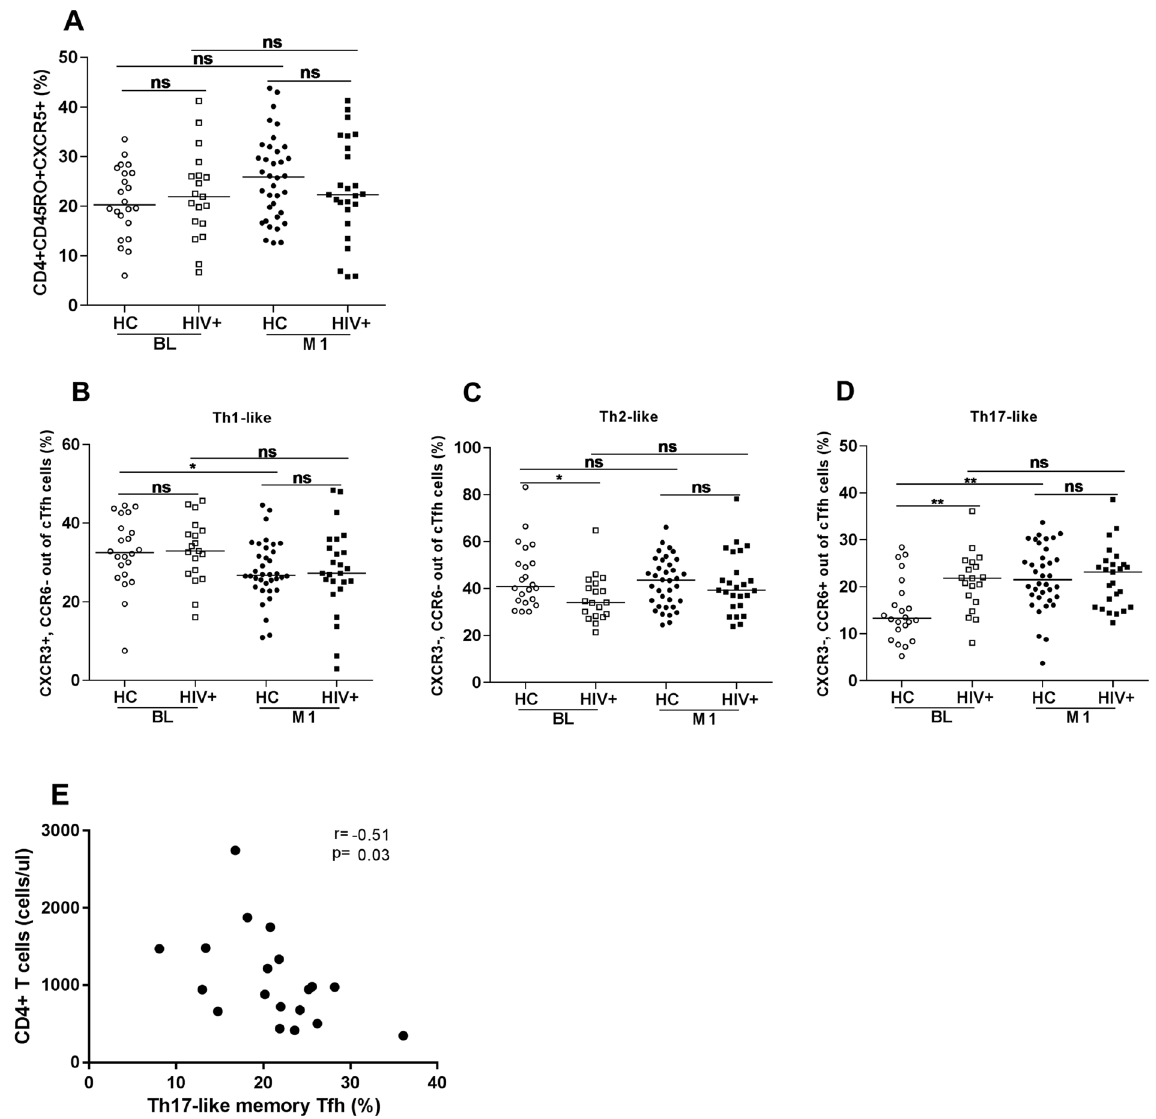
Figure 2. Frequency of cTfh cells and of Th1-, Th2- and Th17-like cTfh cells. The frequency of cTfh cells ( A ) and Th1-, Th2- and Th17-like cTfh cells ( B – D ) was measured in specimens from healthy controls and HIV-1 infected children. 22 healthy controls (HC) and 19 HIV-1 infected children were examined at baseline (BL) and 36 HC and 25 HIV-1 infected children after 1 month from last vaccination. A correlation between CD4 + T cell count and Th17-like cTfh cells was found at baseline in HIV-1 infected children ( E ). Unpaired and paired T test was used to calculate the differences between and within the groups. ns = not statistical significant, * p < 0.05, and ** p <